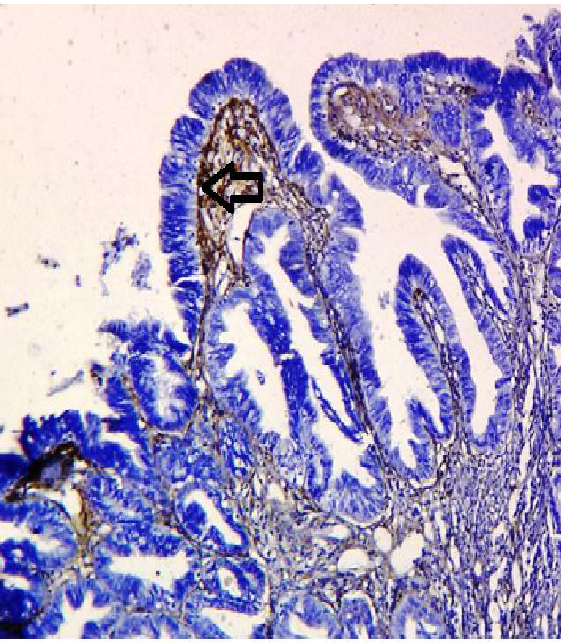
Figure 4: IHC of serous borderline tumor with anti type IV collagen showing continuous linear (+++), expression of type IV collagen, (arrow), (10X).